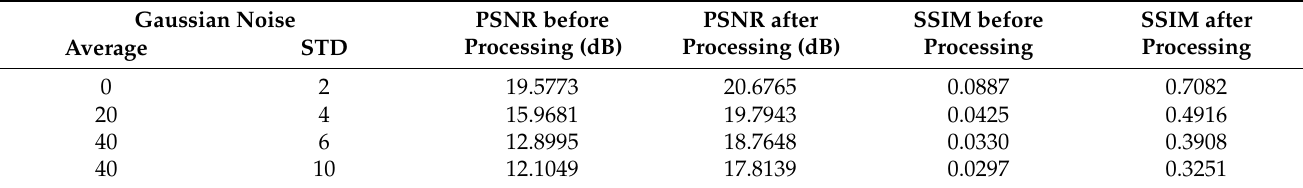
Figure 5. Comparison between the ( a ) ground truth image, ( b ) the blurred and noised image, and ( c ) the DWDC-processed image. Here, Gaussian noise with an average value of 0 and a standard deviation of 2 was applied to the ground truth to generate ( b ). Table 1. PSNR and SSIM of the ground truth images applied with Gaussian noise and after DWDC